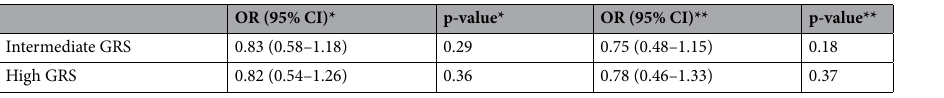
Table 2. Odds ratios (OR) for intermediate and high genetic risk scores (GRS 50) for CVD death in childless men as compared to fathers (reference). MDC—CVC cohort. *Crude analysis. **Models adjusted for: age, smoking, alcohol, BMI, hypertension, family history of CI, cholesterol, triglycerides, marriage